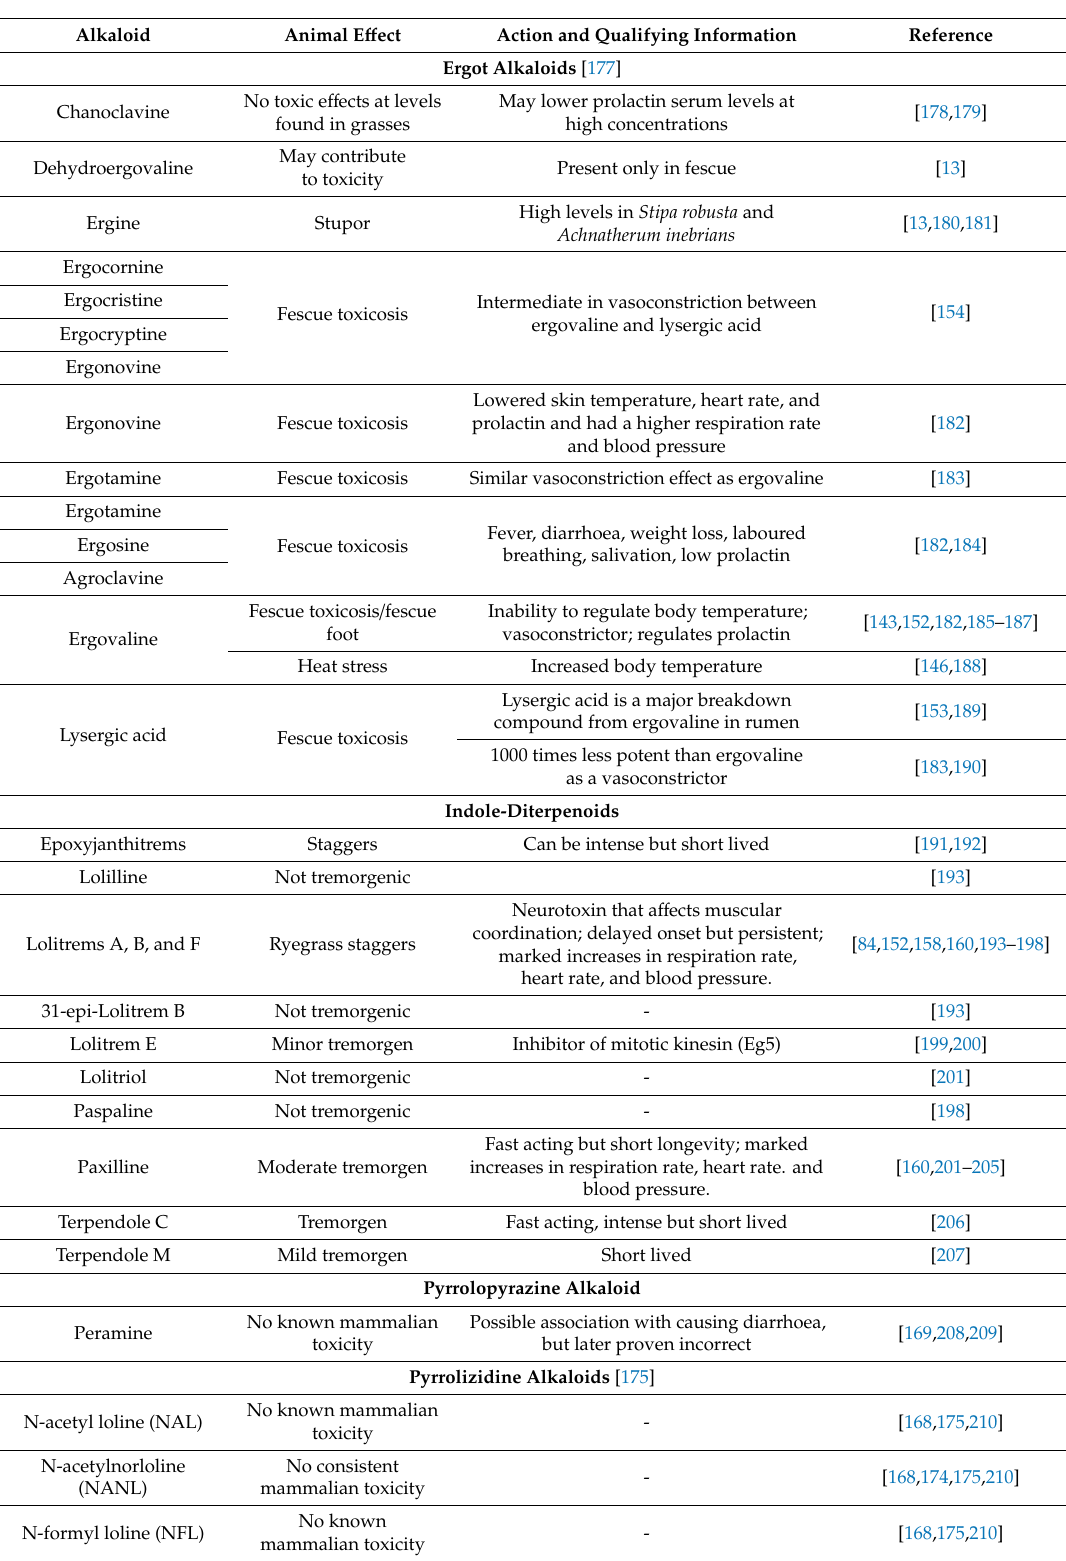
Table 2. Documented e ff ects of alkaloids expressed by Epichloë on animal health and welfare. Alkaloid Animal E ff